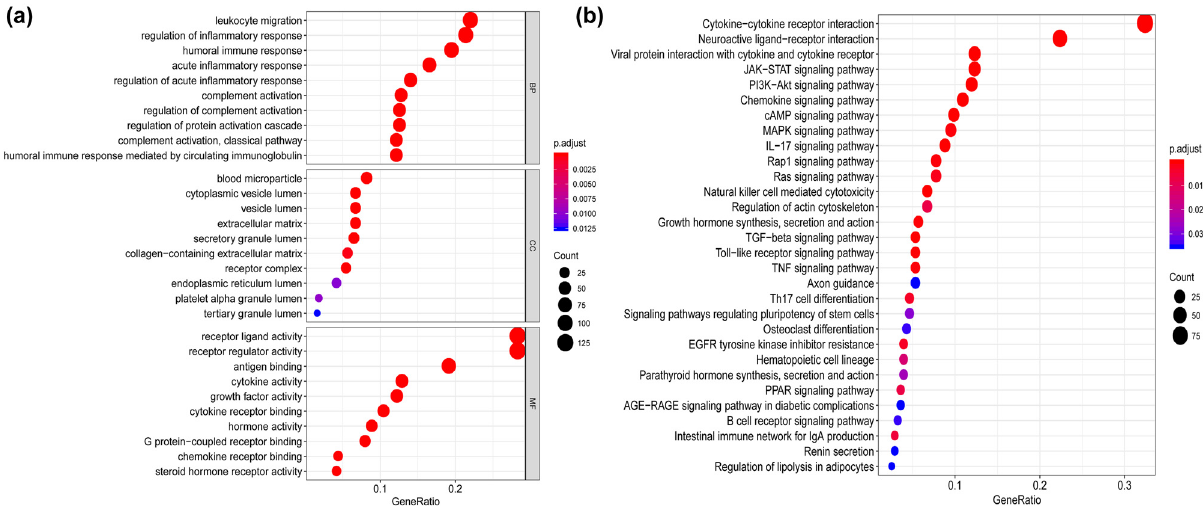
Figure 5: Gene functional enrichment of the immune - relevant signature. ( a ) The top ten most signi fi cant GO terms. ( b ) The top 30 most signi fi cant KEGG pathways.